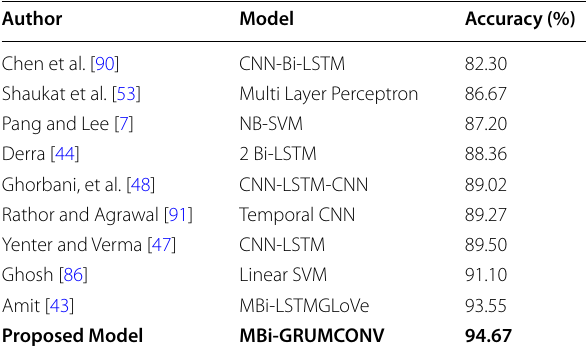
Table 13 Comparison of the validation accuracy results of the proposed model with those of previous